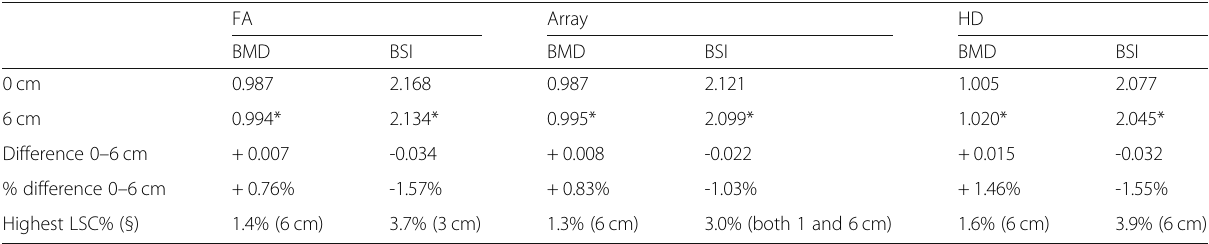
Table 3 Comparison of BMD and BSI mean values at 0 and 6 cm of pork rind layers for each scan modality